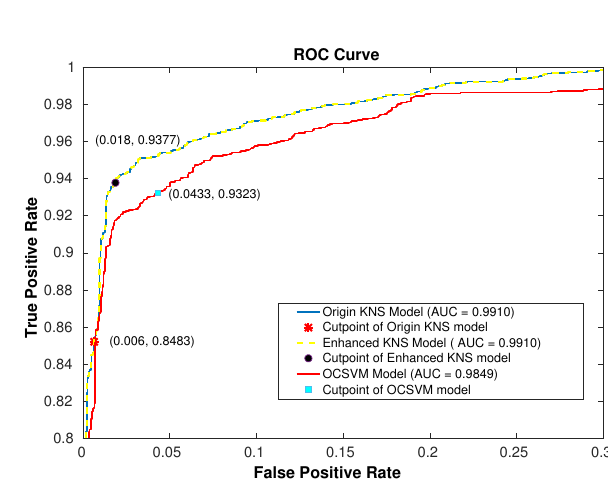
Figure 8. ROC-Curve of the EKNS, original Kernel Null Space, and OCSVM of separability between two or more di ff erent classes. A model whose predictions are 100% wrong has an AUC of 0.0; one whose predictions are 100% correct has an AUC of